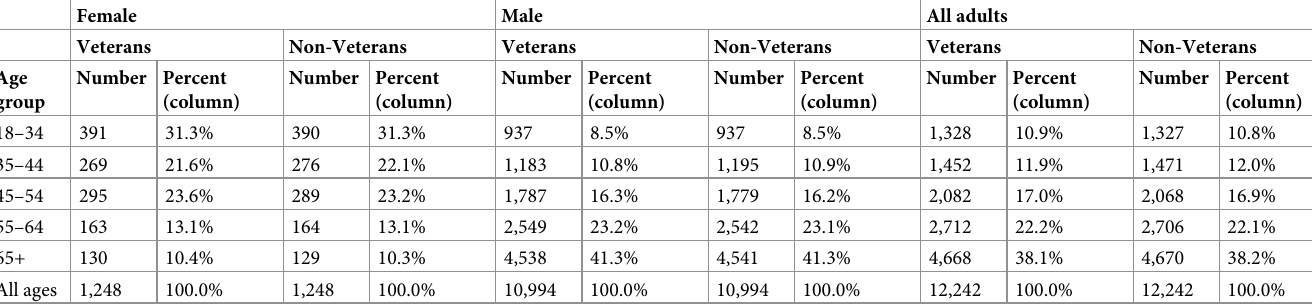
Table 1. American Indian and Alaska Native veterans and non-veterans by age and sex. Fiscal year